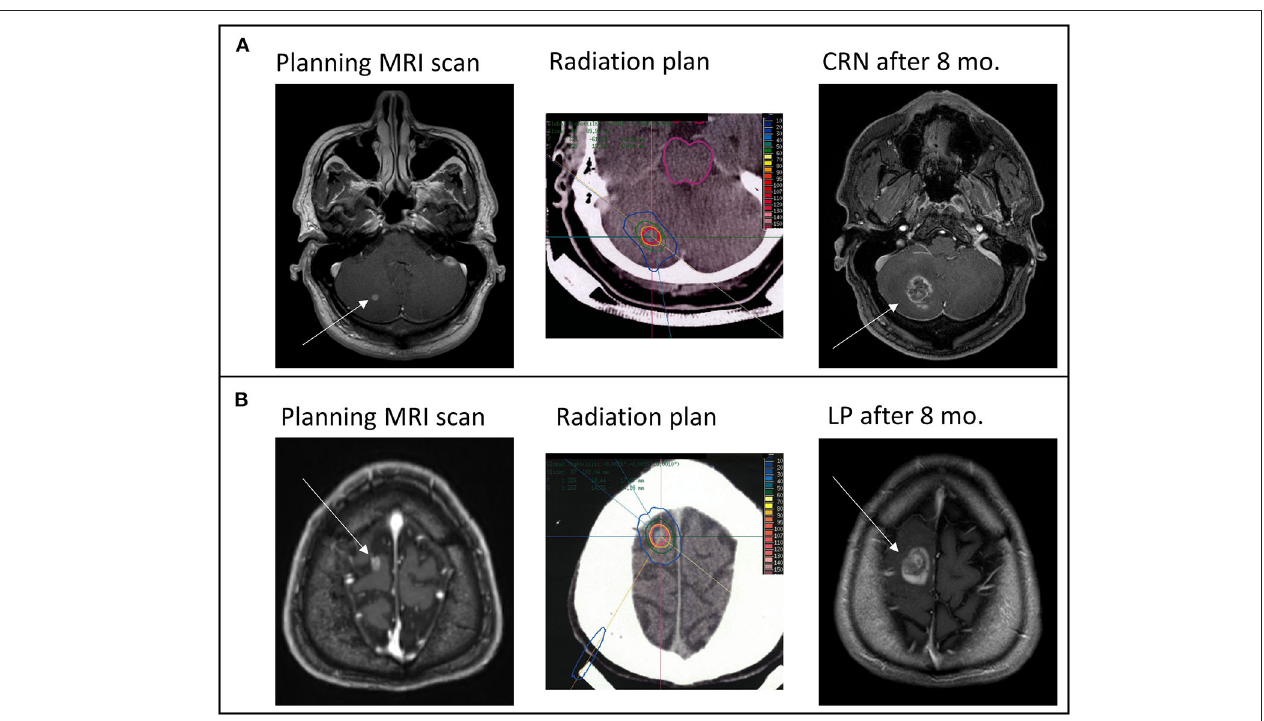
FIGURE 1 | From left to right: Pre-treatment T1-weighted axial contrast-enhanced Magnetic resonance imaging (MRI) sequence showing new diagnosed brain metastasis (white arrow), representative slice of the irradiated radiation plan showing isodose lines (red = 100% isodose line) in the planning Computed tomography (CT) and follow up T1-weighted axial contrast-enhanced MRI sequence of (A) an histological confirmed CNS radiation necrosis (CRN) and (B) an histological confirmed local progression (LP) ∼ 8 months (mo.) after combined treatment of checkpoint-inhibition and stereotactic